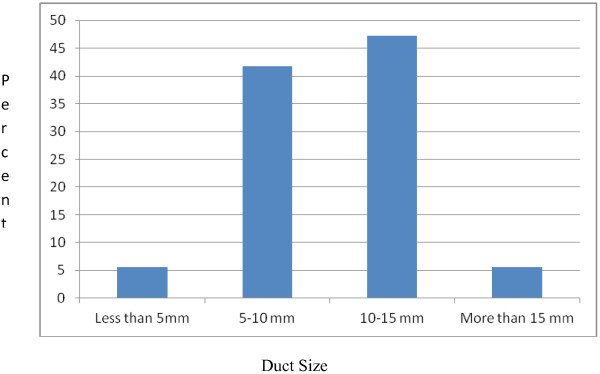
Distribution of the duct size across the cohort of patients who underwent surgical closure at the cardiac center, Ethiopia, 2009–2012.